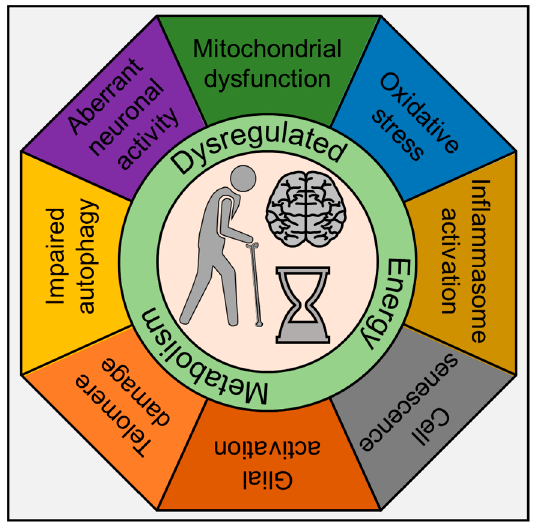
Figure 1. Schematic diagram depicts the various cellular pathways implicated in inflammaging.